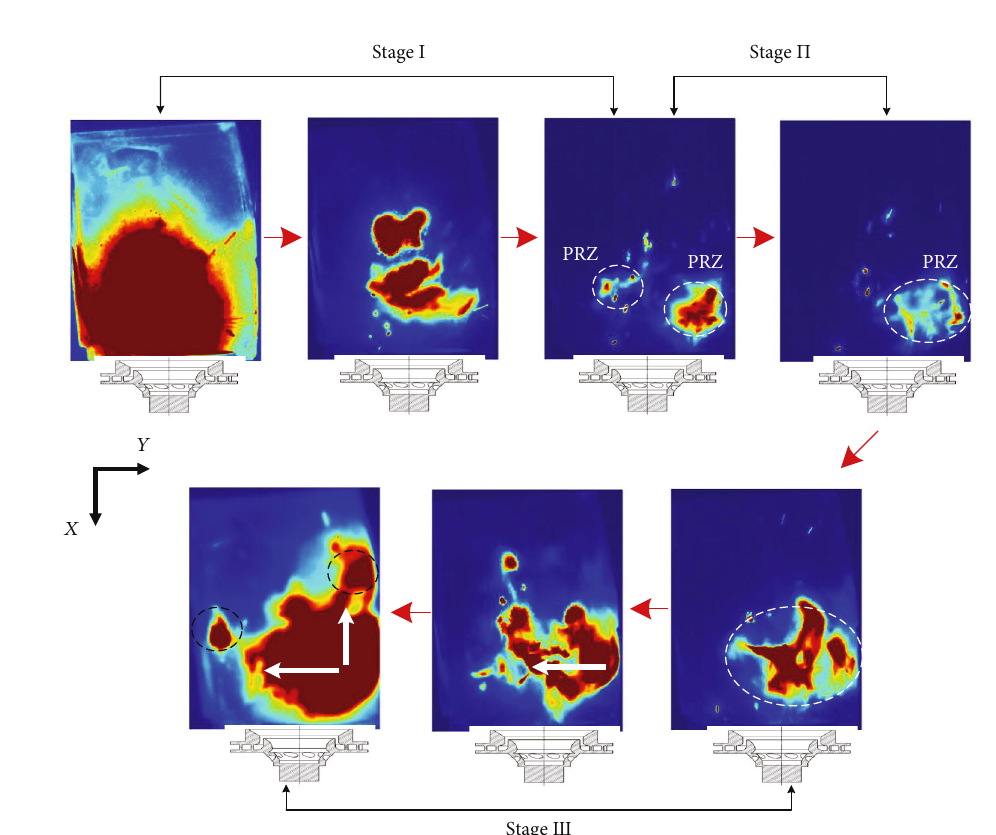
Figure 7: Ignition process of the combustor (by rotating the fl ame image clockwise by 90 °